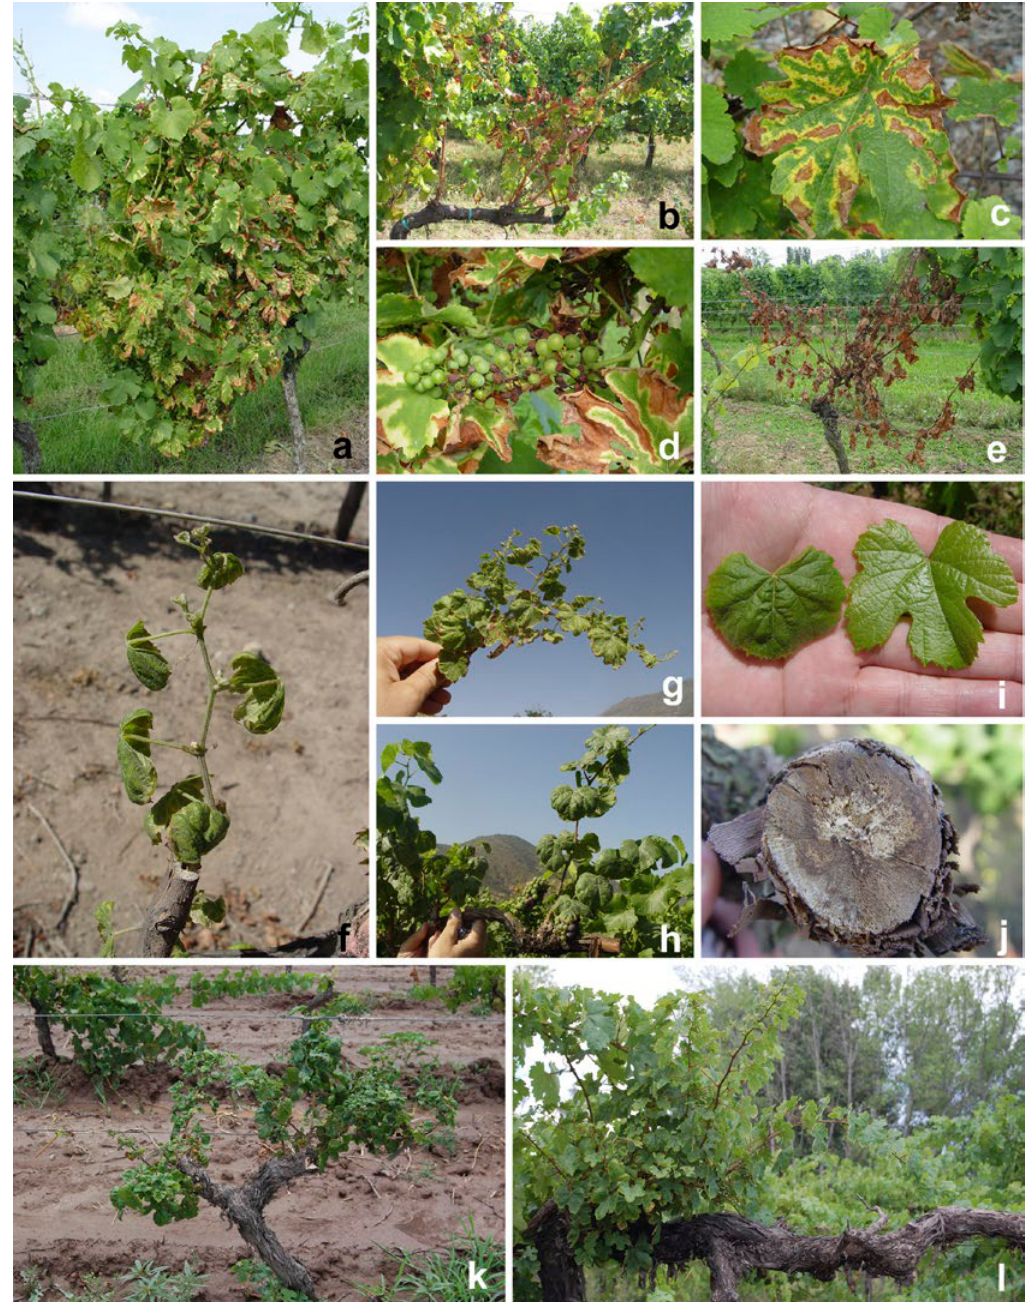
Figure 2. Symptoms associated with esca in Europe, cholorotic leafroll in Chile and hoja de malvón in Argentina. Esca (grapevine leaf stripe disease) symptoms on a white wine grape cultivar in a. Siebeldingen, Germany; b. Tuscany, Italy; c. Mosel, Germany; d. leaf and berry symptoms on white cultivars in Siebeldingen, Germany; e. vine showing apoplexy in Siebeldingen, Germany; Zig-zag shoots typical of choloric leaf roll f. and g. in Santiago, Chile and h. Casablanca, Chile; i. chlorotic leafroll affected leaf (left) vs healthy leaf (right) of Malbec in Talca, Chile; j. trunk of 10-year-old chlorotic leafroll affected vine, Casablanca, Chile; k. and l. typical symptoms of hoja de malvón on grapevines in Argentina (both photos supplied by Cecilia Césari from INTA, Mendoza,